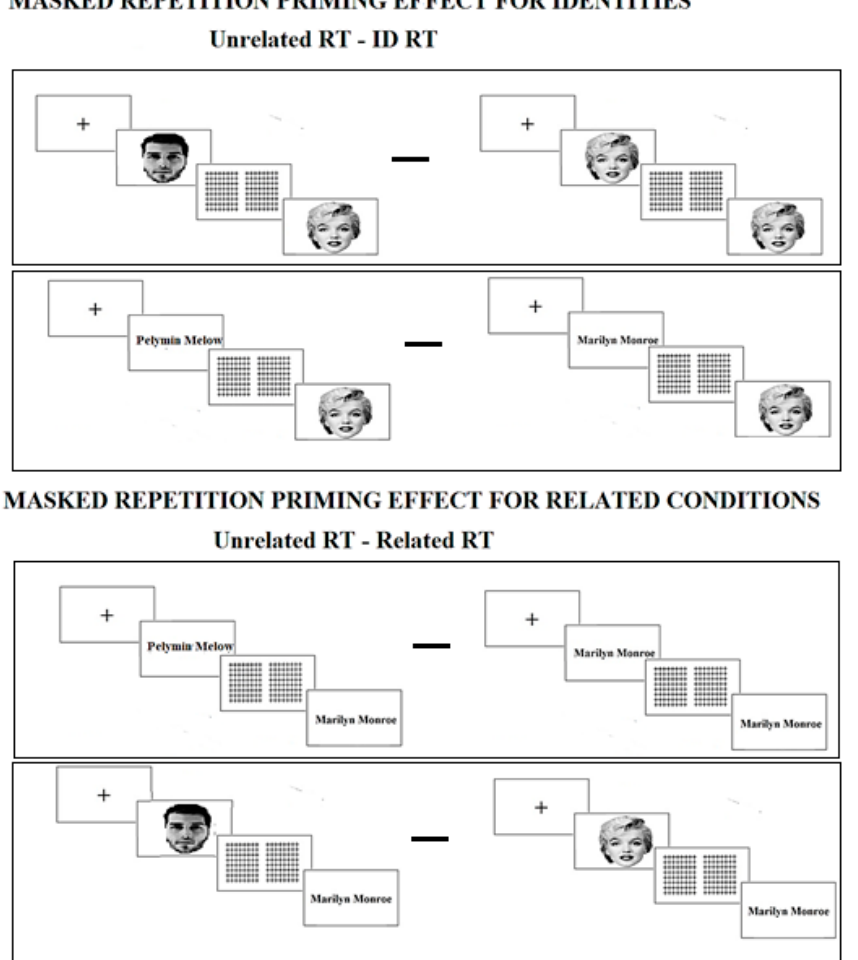
Figure 2. Examples of the related conditions on the masked priming task employed for Experiment 2. On the top, one example of the following block: Unrelated masked face prime / face target–Identity masked condition for faces, and the Unrelated masked word prime / face target–Related masked word prime / face target. On the bottom, one example of the following block: Unrelated masked word prime / word target–Identity masked condition for words, and the Unrelated masked face prime / word target–Related masked face prime / word target.